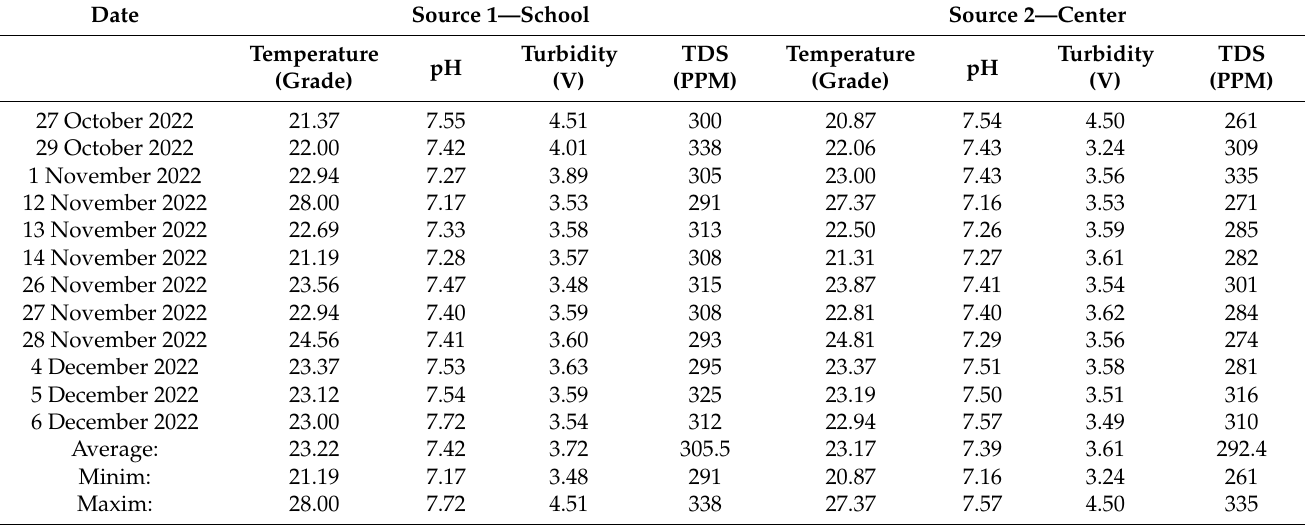
Table 3. Water source one and two results.